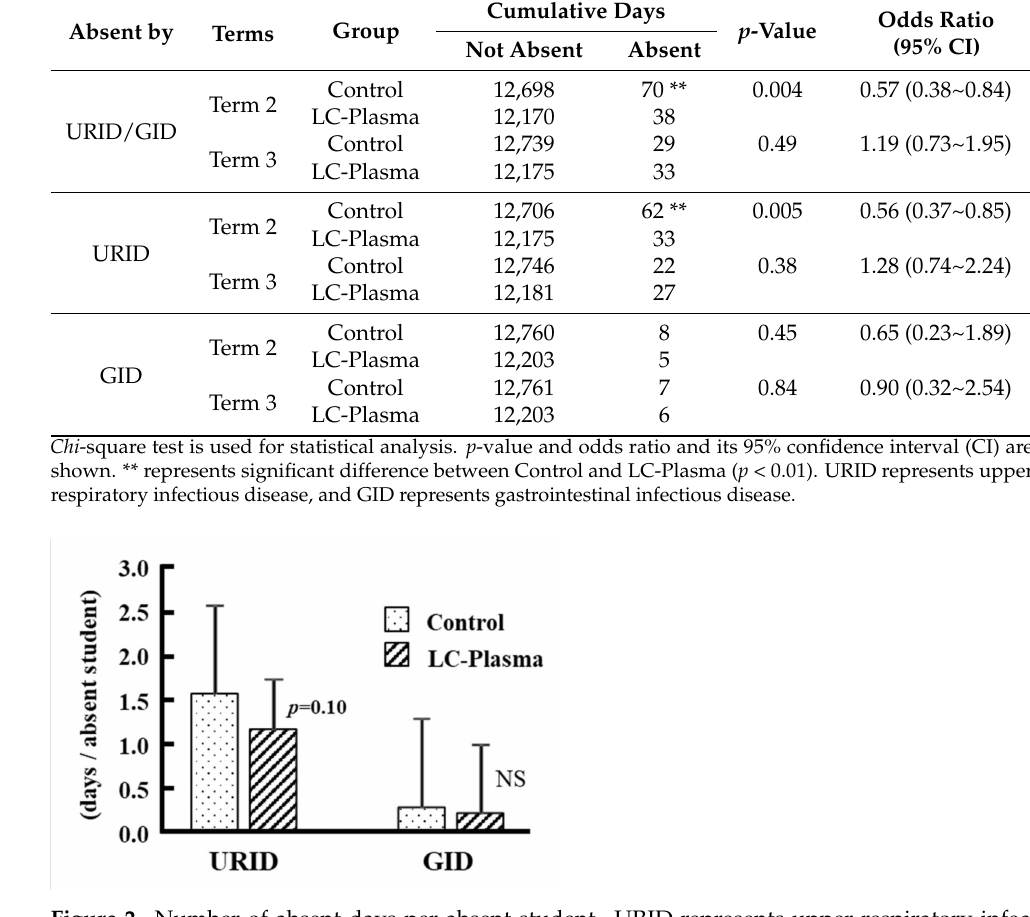
Table 2. Cumulative school absent days caused by disease (URID/GID).